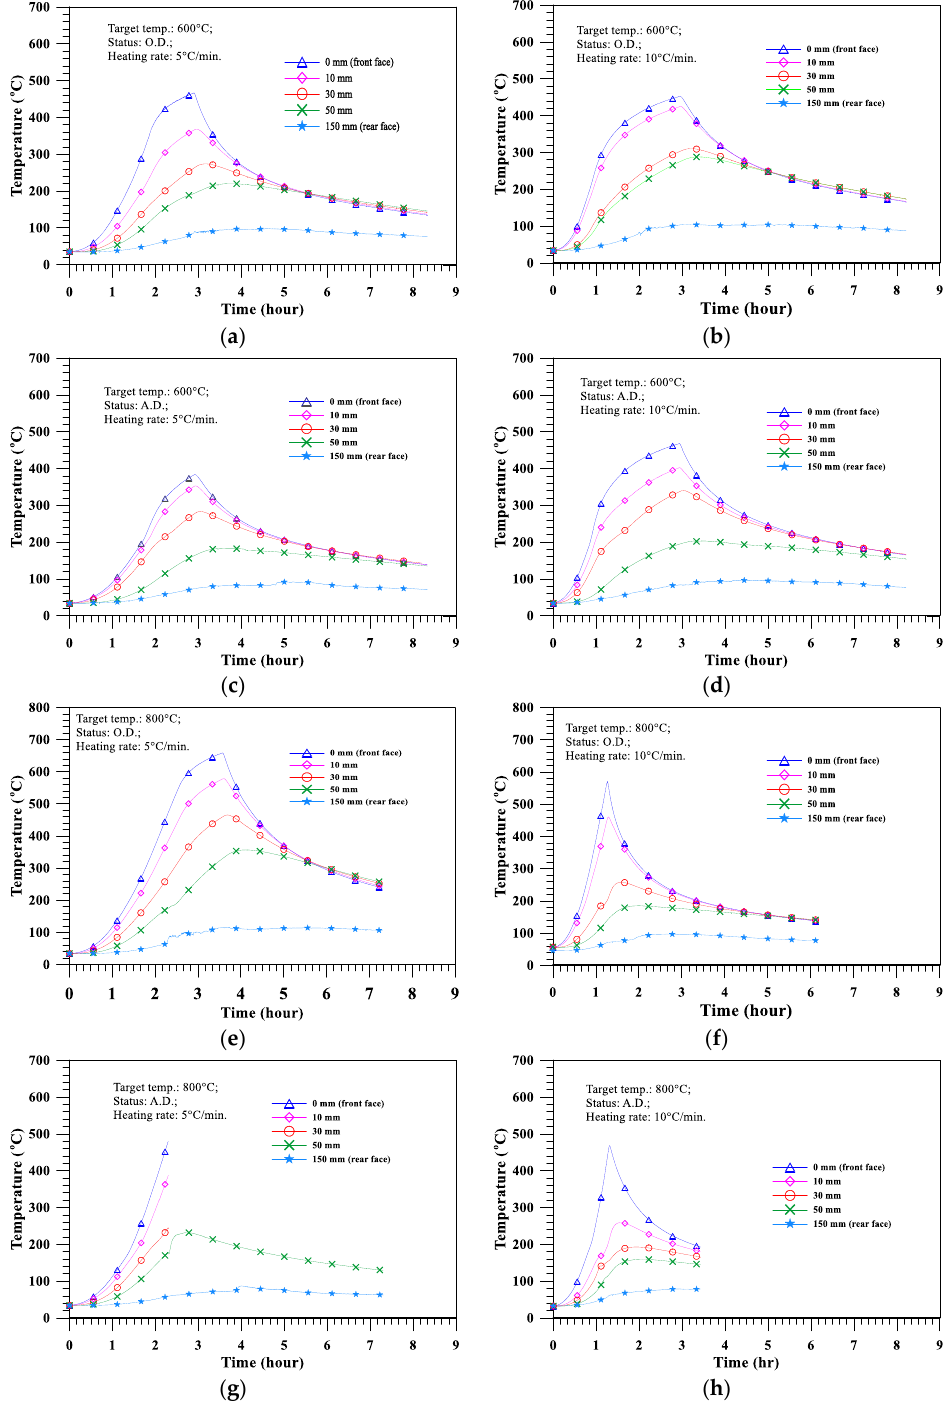
Figure 6. Temperature distribution curves of the heated LWAC slabs: ( a ) L-OD-600-R5; ( b ) L-OD- 600-R10; ( c ) L-AD-600-R5; ( d ) L-AD-600-R10; ( e ) L-OD-800-R5; ( f ) L-OD-800-R10; ( g ) L-AD-800-R5; ( h ) L-AD-800-R10.